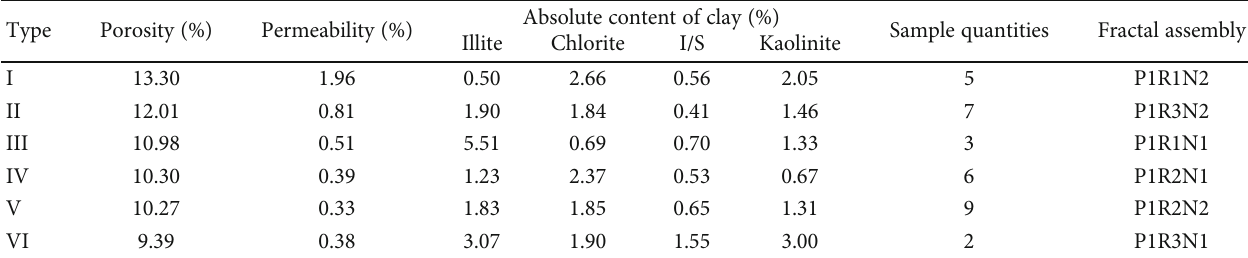
Table 1: Petrological and petrophysical property characteristics based on the statistical average from type I to type VI of H8 tight sandstones. Type Porosity